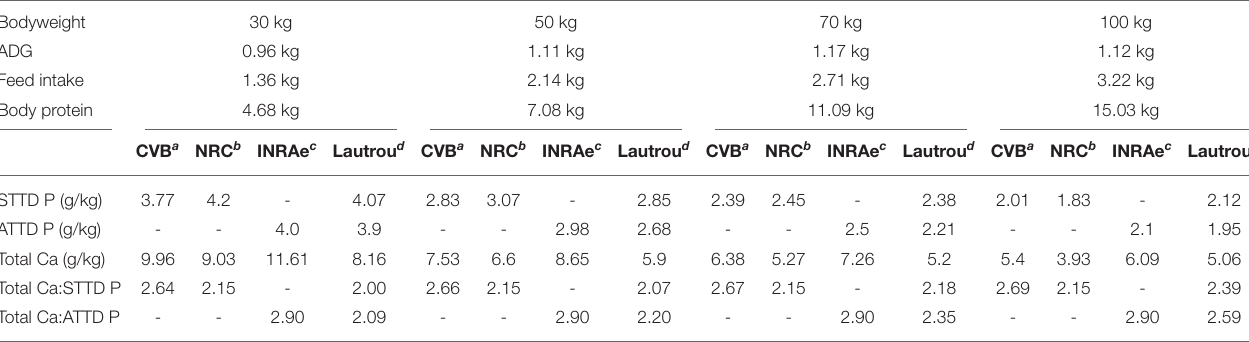
TABLE 1 | Estimates of P and Ca requirements for growing pigs according to different models. Bodyweight